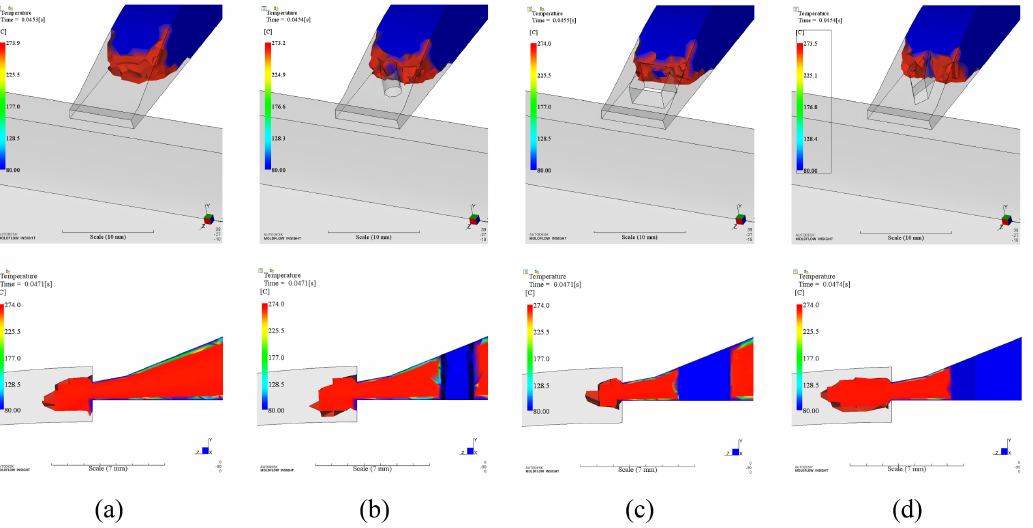
Figure 10. Temperature of melts before entering the cavity: ( a ). Without insert; ( b ). Circular insert; ( c ). Rectangular insert; ( d ). Diamond insert.